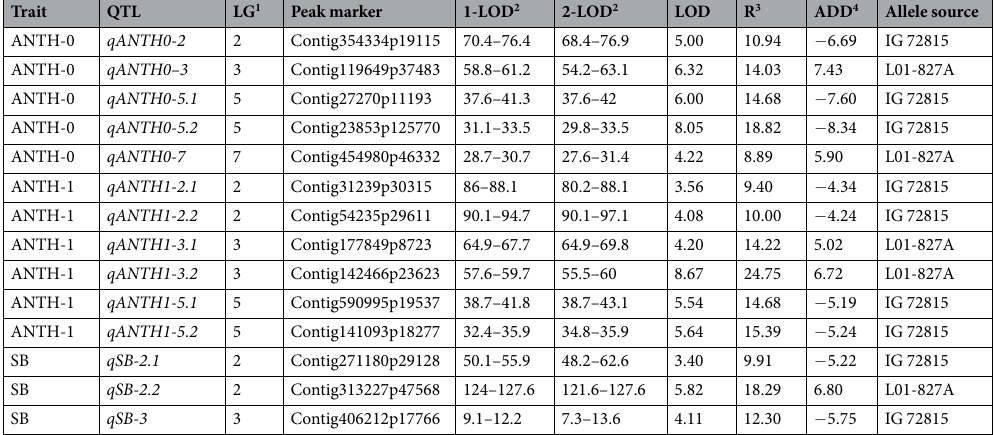
Table 2. QTLs controlling resistance to Colletotrichum lentis CT-30 (race 0, ANTH-0) and CT-21 (race 1, ANTH-1), Stemphylium botryosum (SB) in the Lens ervoides L01-827A × IG 72815 RIL population. 1 LG, Additive genetic effect. Positive and negative signs indicate that alleles for the corresponding traits are derived from the parental accessions L01-827A and IG 72815,